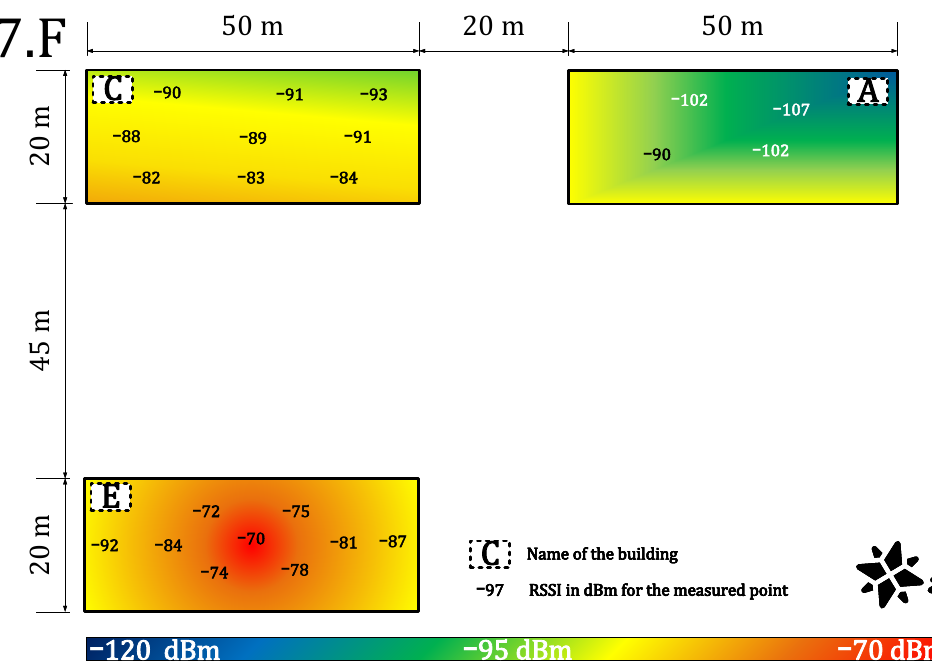
Figure 7. Private network coverage and signal propagation on the seventh